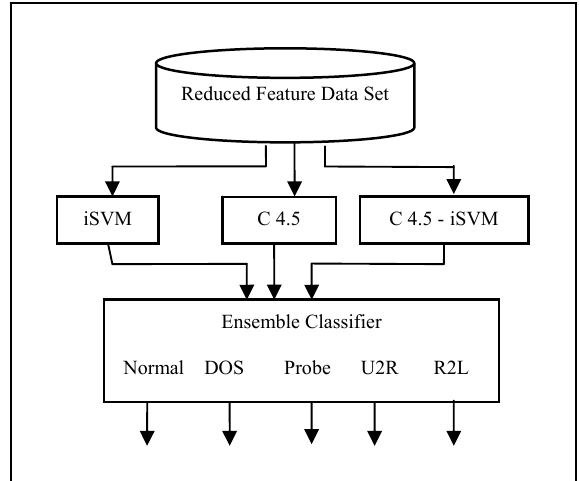
Fig. 2. Architecture of Ensemble